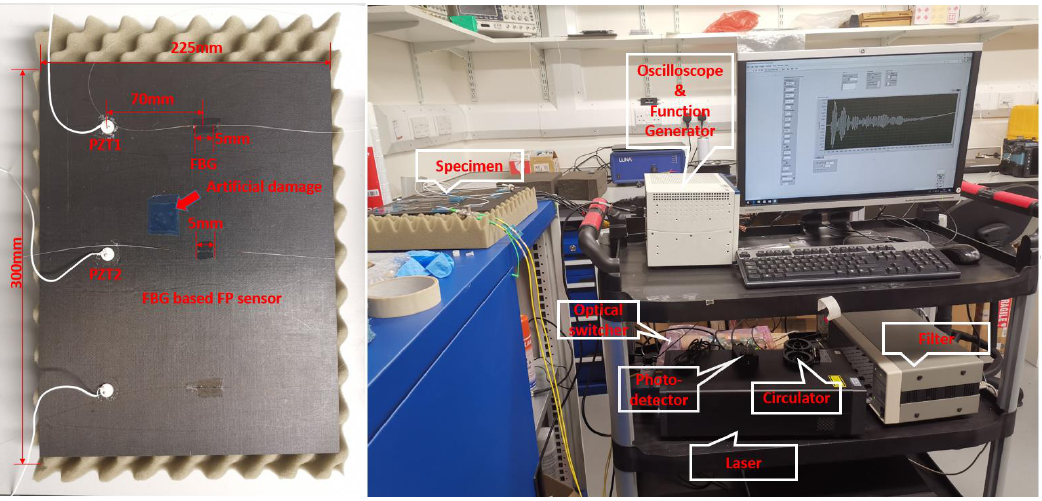
Figure 13. Experimental set up.